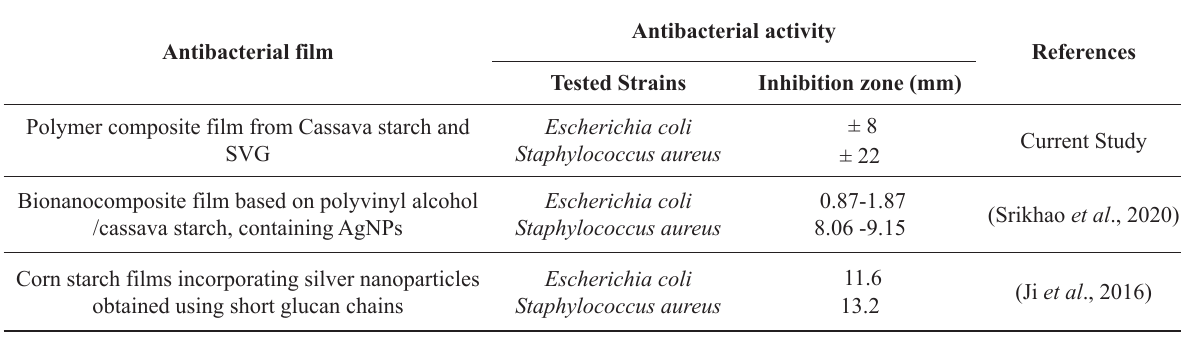
Table 2: Comparison of antibacterial activities of polymer composite films based on starch and silver nano particles.